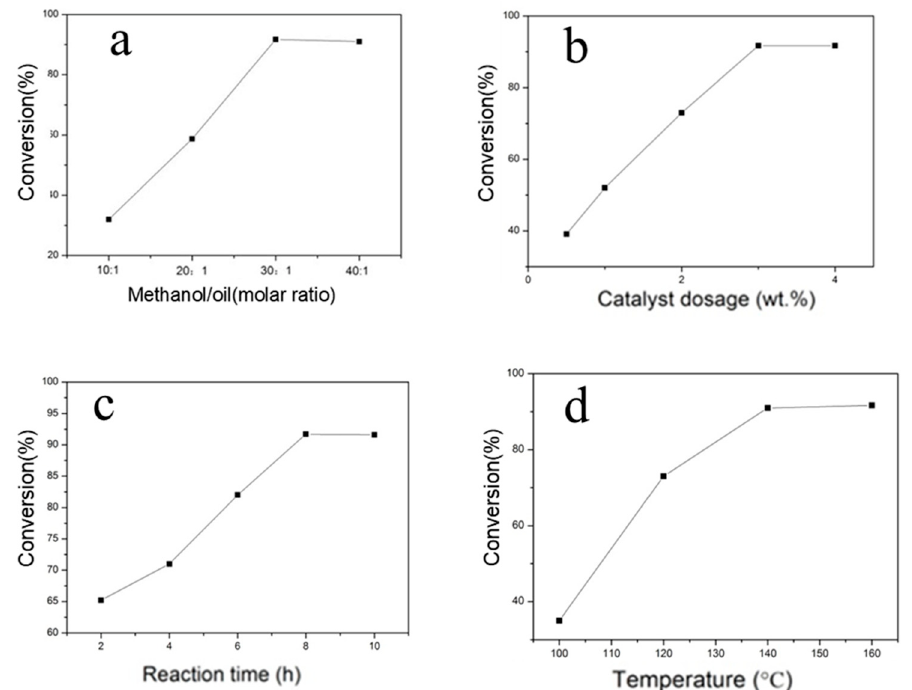
Figure 5. Influence of methanol / oil molar ratio ( a ), catalyst dosage ( b ), reaction time ( c ) and reaction temperature ( d ) on the oil conversion over the Cs 2 H 4 PV 3 MoW 8 O 40 catalyst.